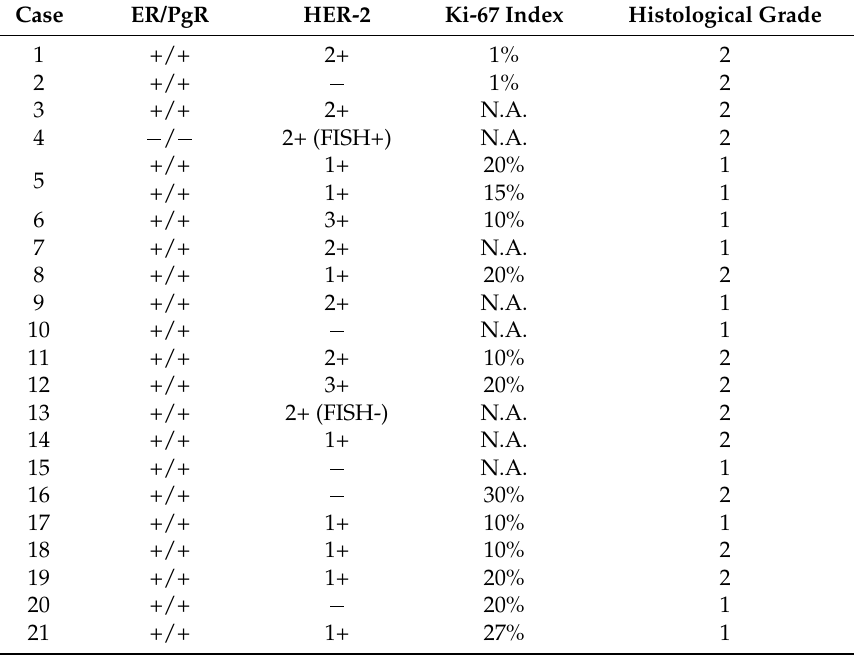
Table 2. Histological characteristics of breast